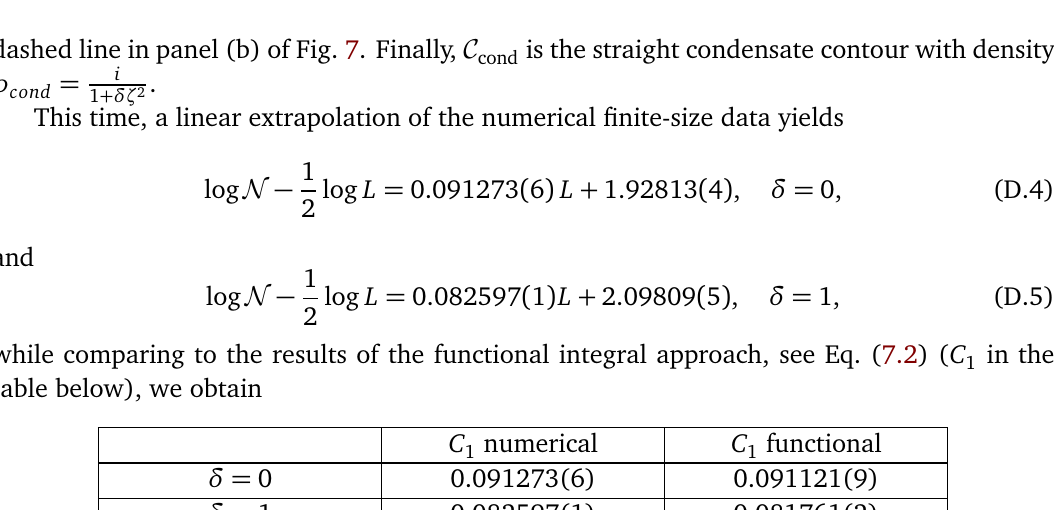
Figure 12: Logarithm of the Gaudin norm, shown for the one-cut solution with n = 1 and ν = 0.1. Green circles (black crosses) show numerical results for δ = 0 ( δ = 1), respectively. Linear fits are indicated by dashed